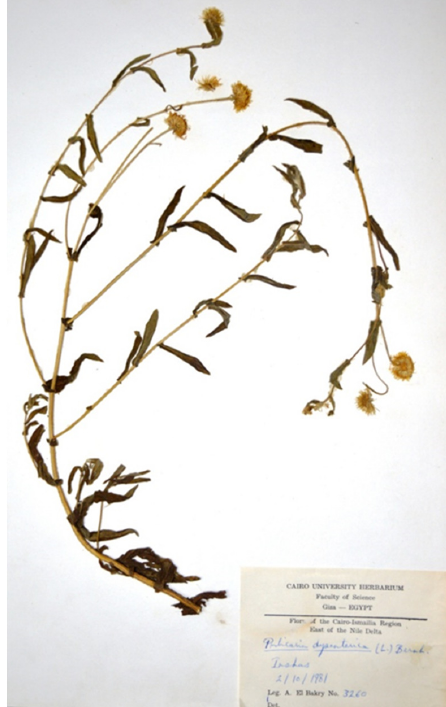
Figure 2. Image of one herbarium specimen of Pulicaria